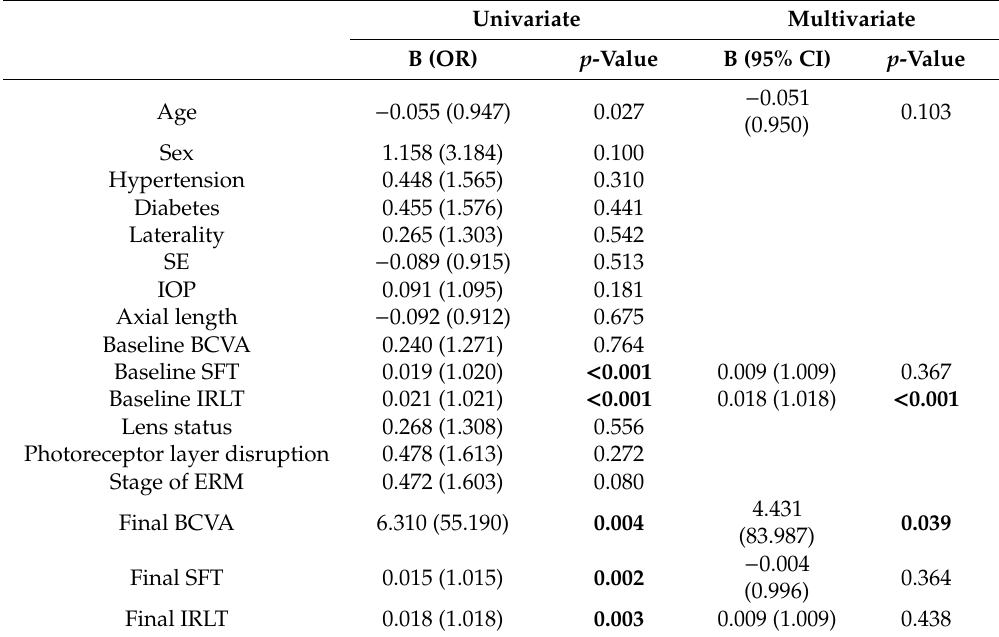
Table 5. Univariate and multivariate logistic regression analyses for determining the factors associated with internal limiting membrane